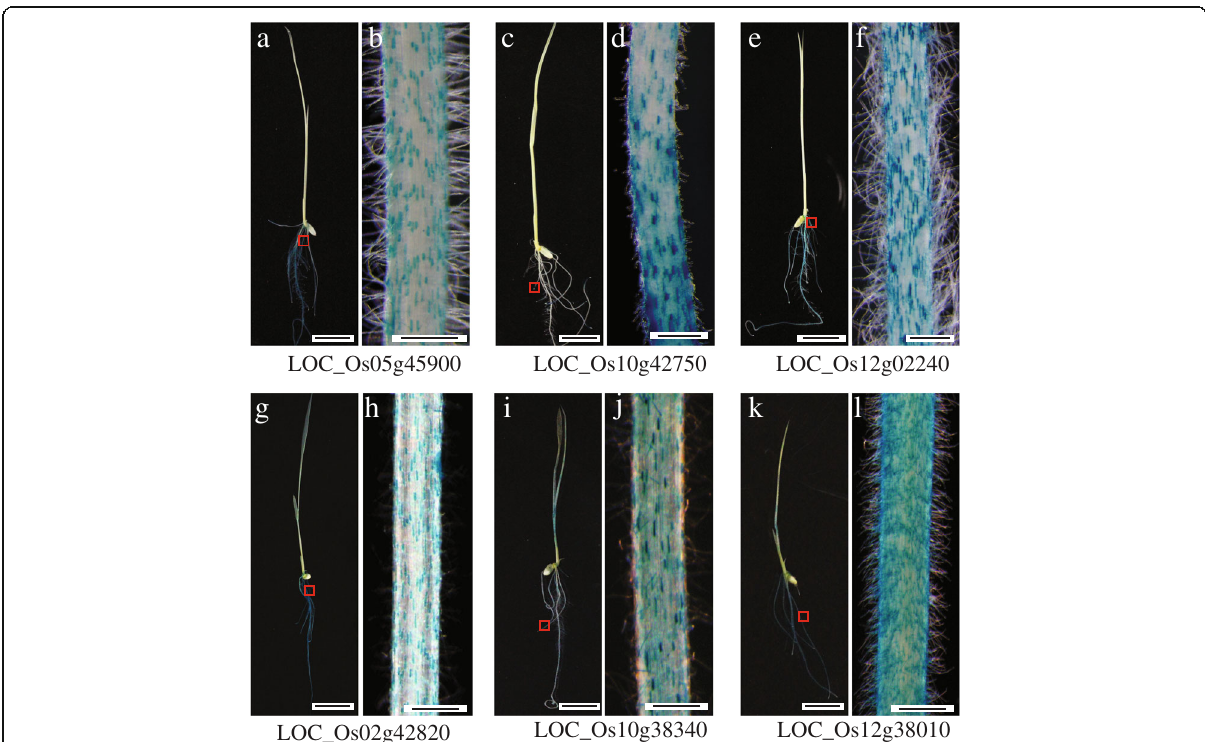
Fig. 2 Validation of genes predominantly expressed in rice root hairs, using GUS reporter system. a to f , Expression patterns for reporter genes from promoter trap lines having T-DNA insertion within LOC_Os05g45900 ( a and b ), LOC_Os10g42750 ( c and d ), or LOC_Os12g02240 ( e and f ). g to l, GUS expression in root hairs from transgenic plants harboring LOC_Os02g42820 promoter::GUS construct ( g and h ), LOC_Os10g38340 promoter::GUS construct ( i and j ), or LOC_Os12g38010 promoter::GUS construct ( k and l ). Scale bar = 1 cm ( a , c , e , g , i , and k ) and 1 μ m ( b , d , f , h , j , and l